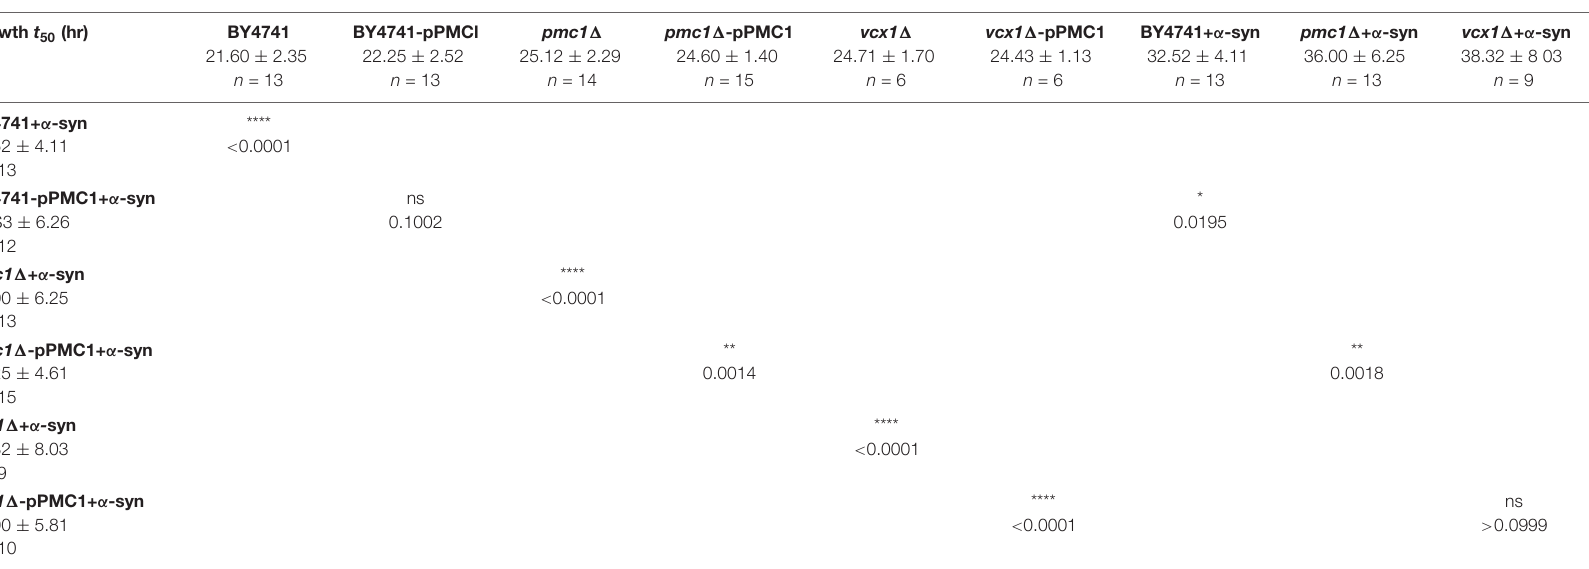
pmc1 (cid:49) pmc1 (cid:49) -pPMC1 25.12 ± 2.29 24.60 ± 1.40 n = 14 n = 15 **** < 0.0001 ** 0.0014